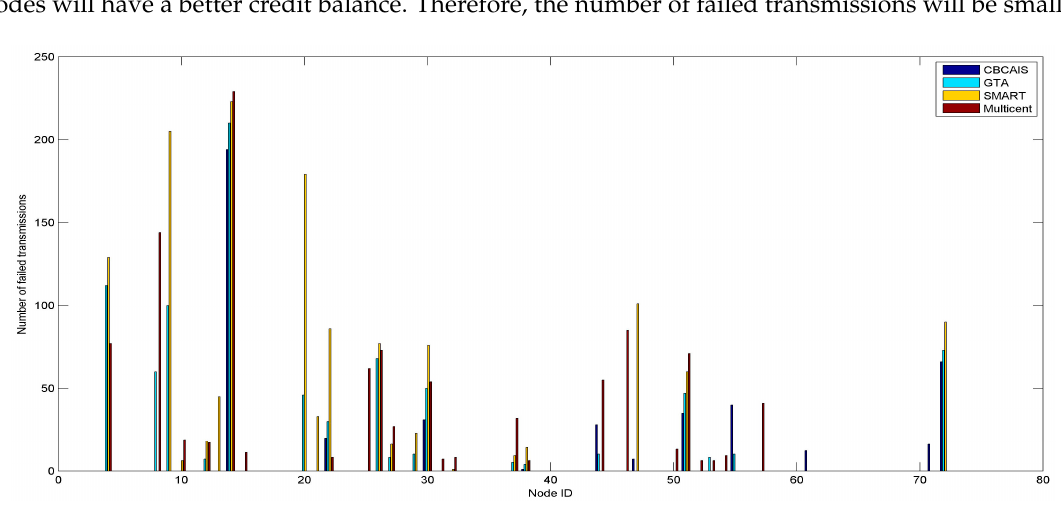
Figure 8. Number of failed transmissions.